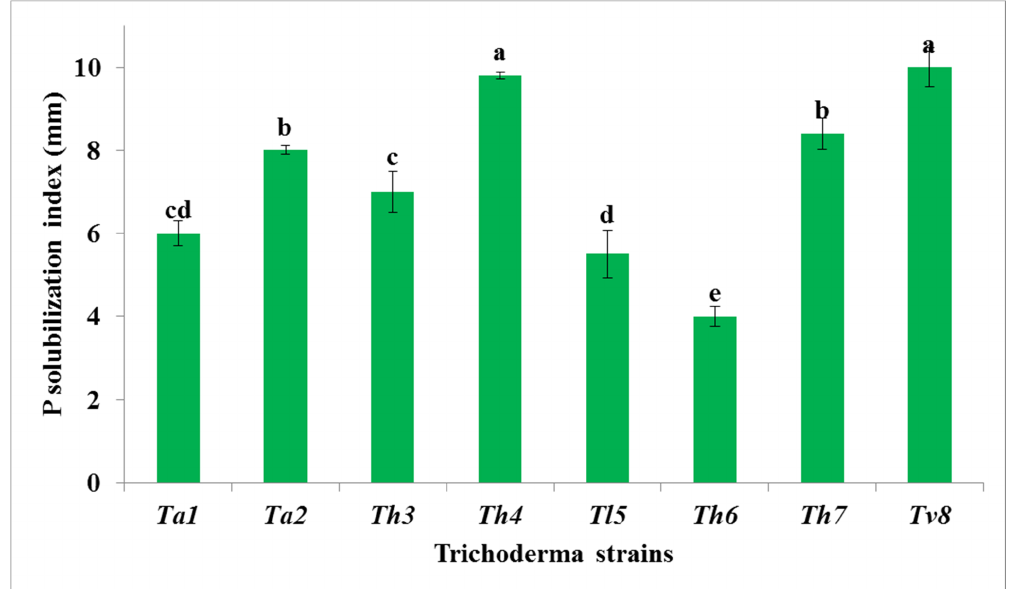
Figure 3. Growth of Trichoderma species on Modified Pikovskaya’s Agar medium (MPA) supplemented with Rock Phosphate (RP) for phosphate -solubilization after seven days’ incubation at 28 ± 0.2 °C. Ta1 = Trichoderma asperlum; Ta 2 = Trichoderma asperlum; Th3 = Trichoderma harzianum; Th4 = Trichoderma harzianum; Tl5 = Trichoderma longibrachiatum; Th6 = Trichoderma harzianum; Th7 = Trichoderma harzianum; Tv8 = Trichoderma viride.